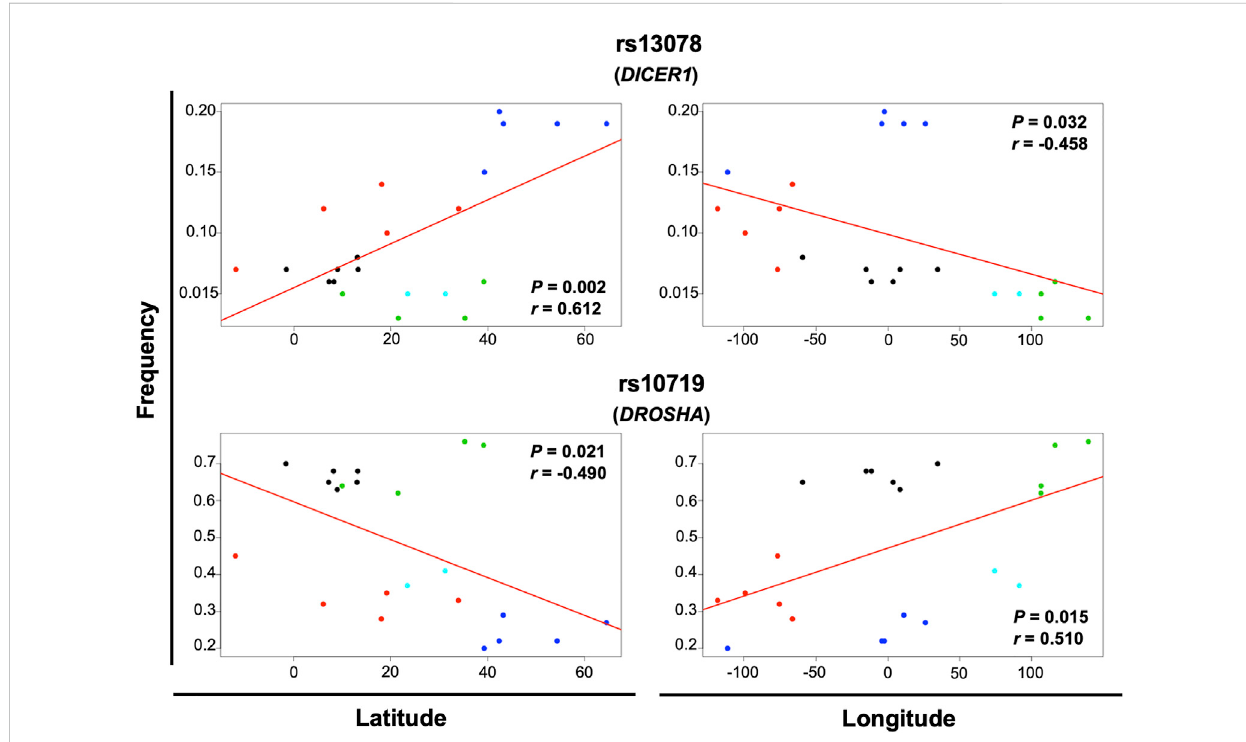
FIGURE 4 Signi fi cantcorrelationoftheminor allelefrequencyofSNVswithlatitudeandlongitude.Thecorrelationofminorallelefrequenciesreportedinsub- continental populations from the 1,000 Genome project and those found in this study for the MEZ population with longitude and latitude was evaluated by the Pearson ’ s correlation test. Gene variants with p < 0.05 for latitude and longitude correlation are shown in the fi gure. Black dots = African groups; red dots = Admixed Latino American groups; blue dots = European groups; green dots = East Asian groups; turquoise dots = South Asian